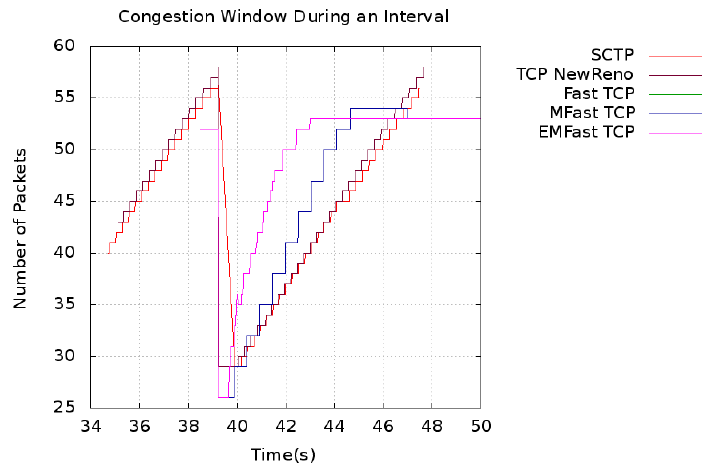
Figure 8. Congestion window graph during the interval of packet drop and after fast-recovery stage (without any competitive flow).